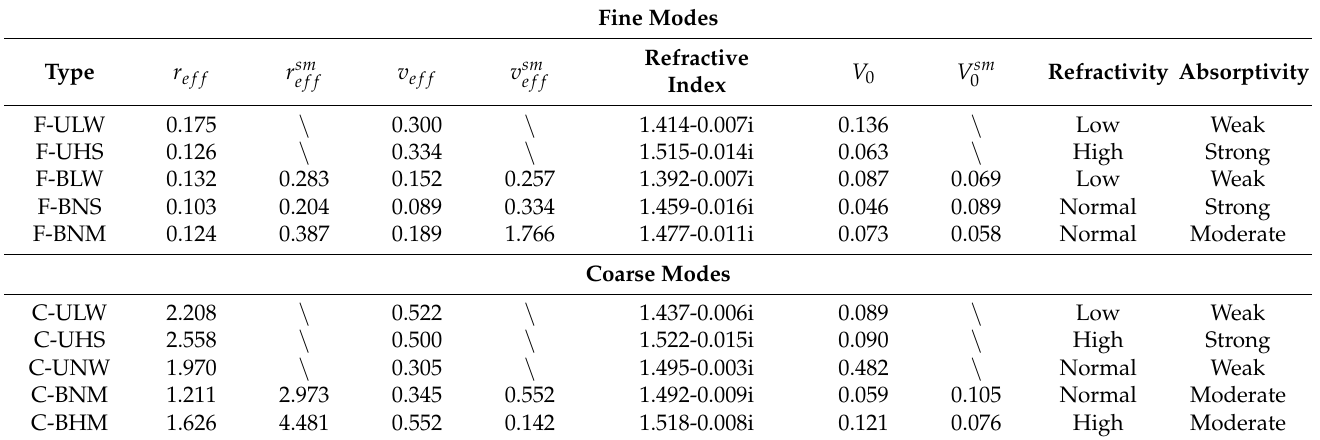
Table 4. Microphysical parameters of ten typical aerosol models in China.